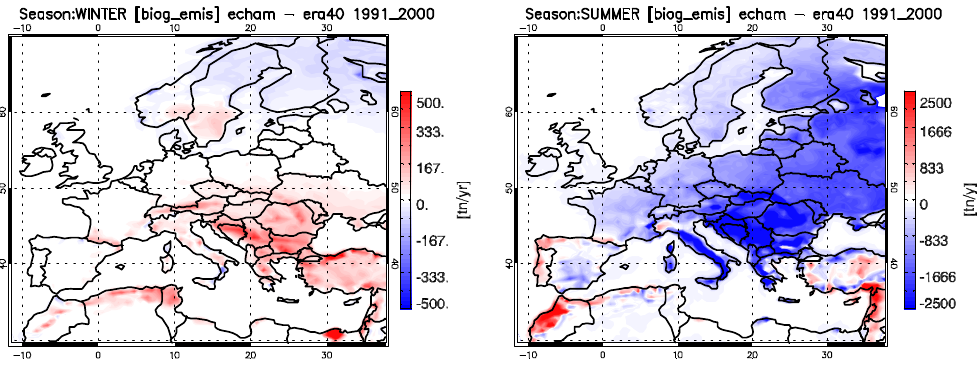
Figure 8. Differences in simulated average biogenic emissions between the ECHAM and ERA for winter (left) and summer (right) representative of the 90s. Mind the differences in color scales for the two seasons.